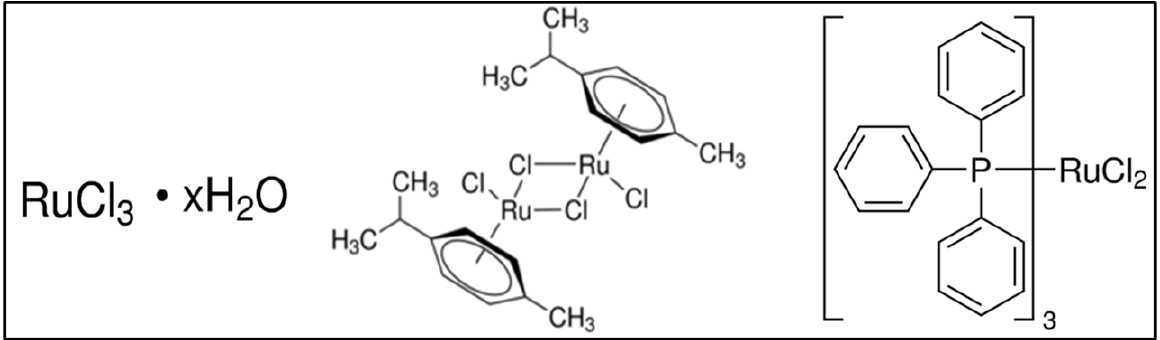
Scheme 1. Structures of the catalyst precursors or starting material. Left: [RuCl 3 ∙ xH 2 O];